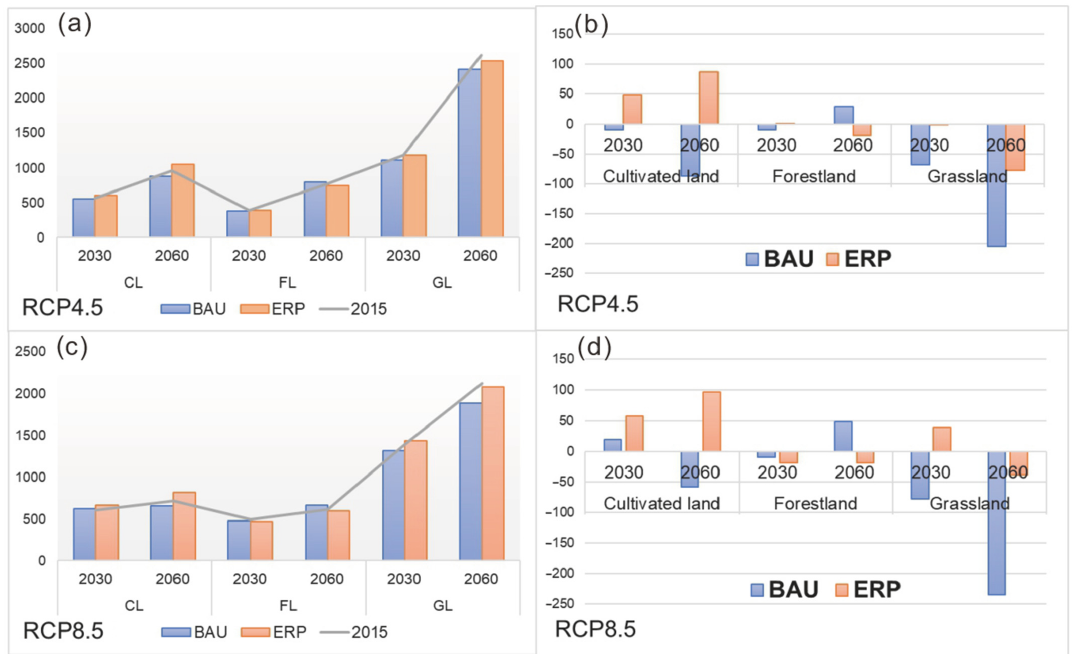
Figure 5. Erosion − induced carbon sinks in two climate change scenarios. (( a ) Soil carbon seques- tration under the SSP2-RCP4.5 scenario by BAU and ERP models; ( b ) carbon sinks in the eroded sedimentary area by BAU and ERP models under the SSP2-RCP4.5 scenario; ( c ) Soil carbon se- questration under the SSP5-RCP8.5 scenario by BAU and ERP models; ( d ) carbon sinks in the eroded sedimentary area by BAU and ERP models under the SSP5-RCP8.5 scenario). From 2030 to 2060, the land types in the BAU pattern, ER pattern and No LUC pat- tern all showed a trend of increase in erosion − induced carbon sinks under the RCP4.5 and RCP8.5 climate scenarios. In the No LUC pattern, the erosion − induced carbon sinks of the cropland, forestland and grassland in the RCP4.5 scenario increased by 402 kg km − 2 , 121 kg km − 2 and 1435 kg km − 2 , respectively. Under RCP8.5, the erosion − induced carbon sinks increased by 111 kg km − 2 , 121 kg km − 2 and 724 kg km − 2 , respectively (Figure 5b, d). In the BAU pattern, the erosion − induced carbon sinks of the cropland and grass- land decreased under the RCP4.5 and RCP8.5 scenarios whereas the erosion − induced carbon sinks of the forestland increased. Under the RCP4.5 scenario, the cropland and grassland in the BAU pattern reduced the erosion − induced carbon sinks by 78 kg km − 2 and 138 kg km − 2 and 77 kg km − 2 and 157 kg km − 2 under the RCP8.5 scenario, respectively. Under the RCP4.5 and RCP8.5 scenarios, the increased erosion − induced soil erosion carbon sink of the forestland in the BAU pattern was 39 kg km − 2 and 58 kg km − 2 , respec- tively. In the ER pattern, the erosion − induced carbon sinks of the forestland and grass- land decreased under the RCP4.5 and RCP8.5 scenarios whereas the erosion − induced carbon sinks of the cropland increased. The forestland in the ER pattern reduced the erosion − induced carbon sinks by 20 kg km − 2 and 78 kg km − 2 under the RCP4.5 and RCP8.5 scenarios, respectively, and the grassland reduced the erosion − induced carbon sinks by 78 kg km − 2 under the RCP8.5 scenario. In the ER pattern, the erosion − induced carbon sinks increased by 39 kg km − 2 under both the RCP4.5 and RCP8.5 scenarios.